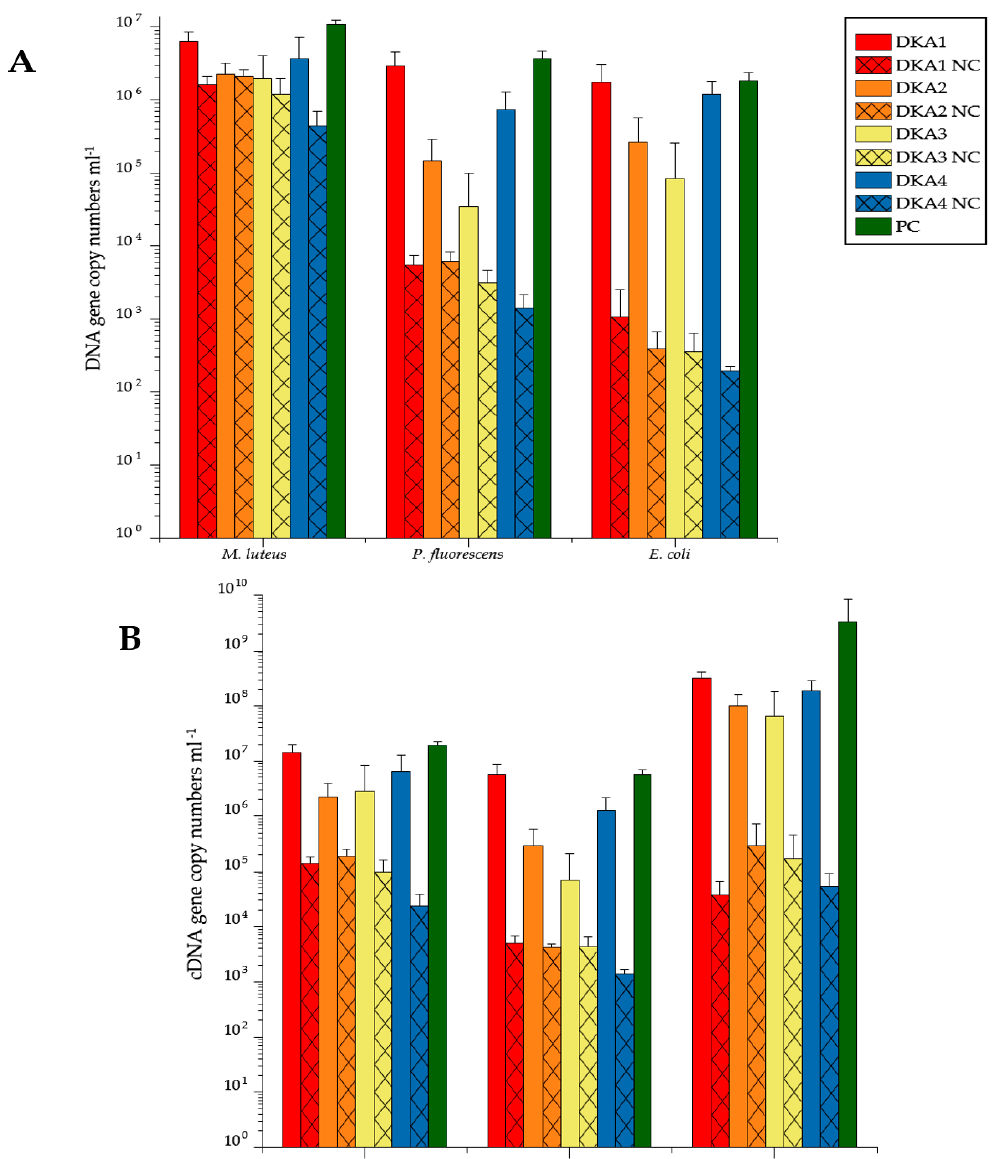
Figure 1. Reduction of artificial external tick-microbiome contaminants after decontamination